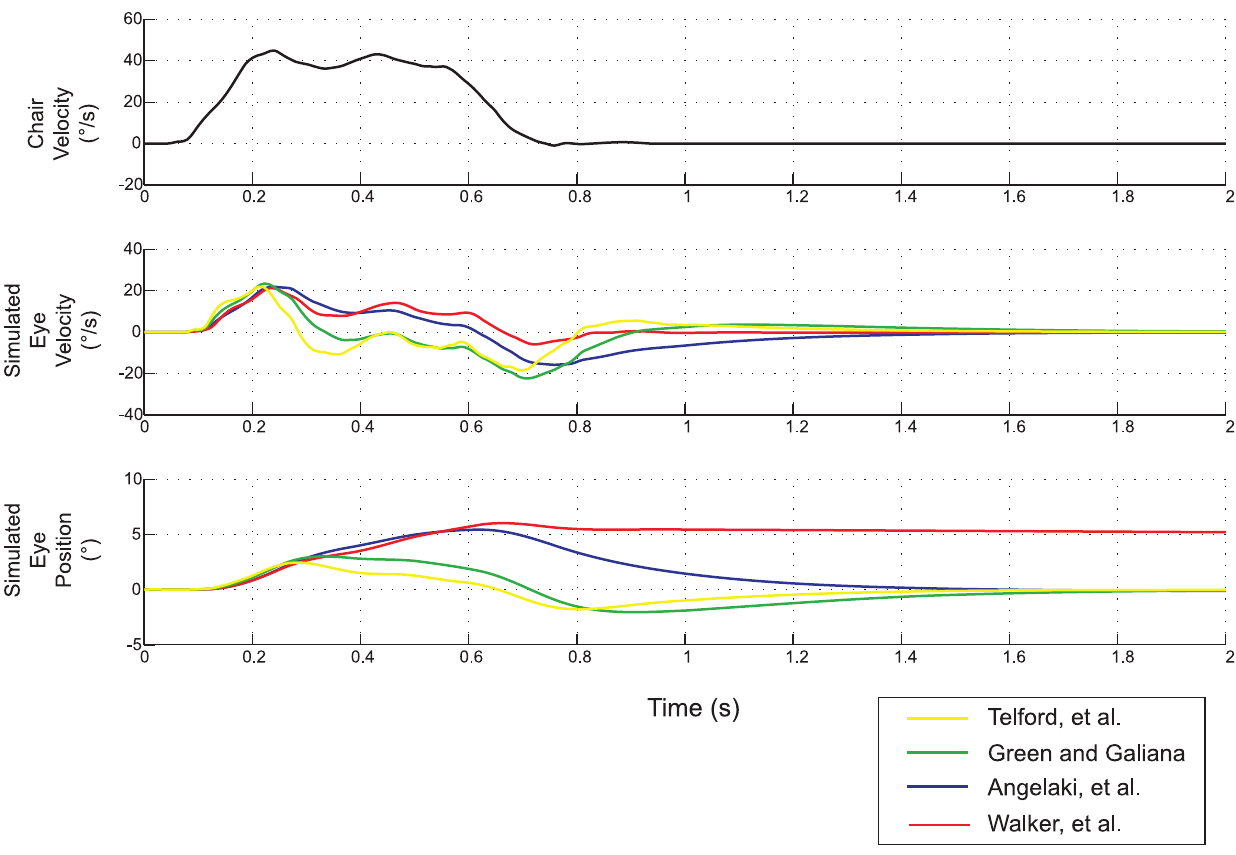
Figure 7. Simulation results for each of the four models. The top panel shows the linear head velocity profile of one of our experimental trials, which was used as the input for each model. The second two panels show simulated eye velocity and position (model outputs).